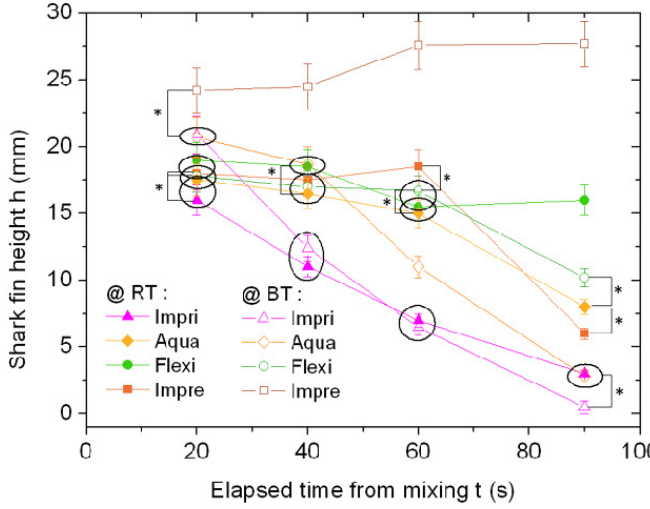
Figure 2. Shark fin test (SFT) measurements for the four materials made at room temperature (RT) (filled symbols) and body temperature (BT) (void